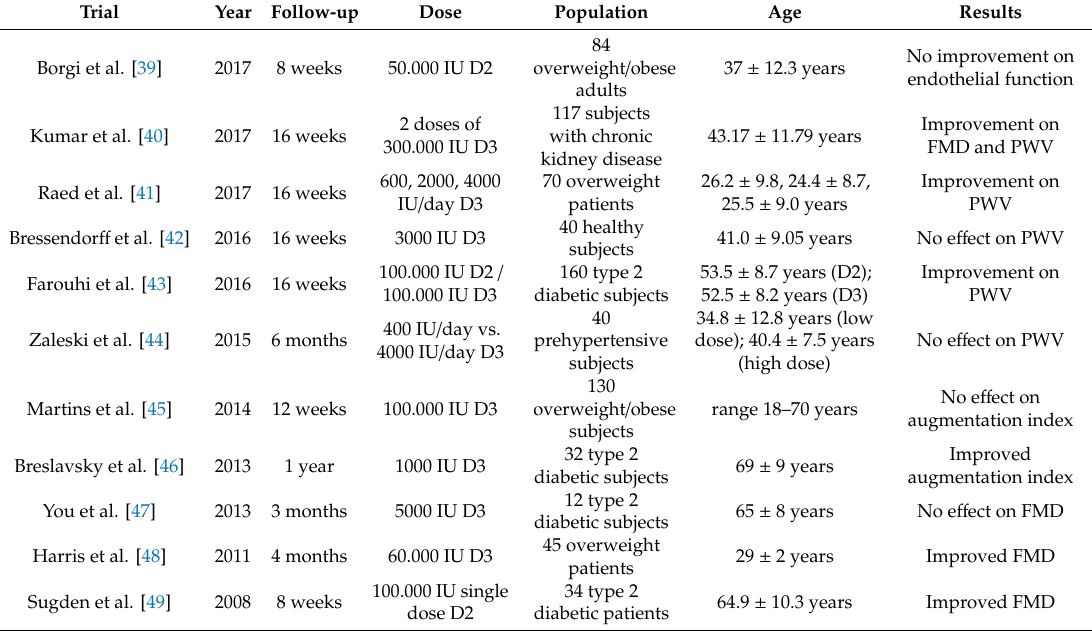
Table 2. E ff ects of vitamin D supplementation on subclinical atherosclerosis in patients without manifest